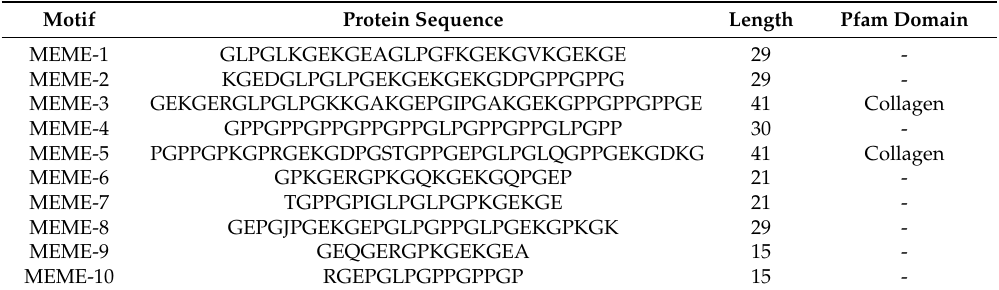
Figure 2. Phylogenetic relationships, motif pattern, gene structure, and conserved protein motifs of buffalo collagen gene family. ( A ) Phylogenetic tree of 45 collagen proteins. ( B ) Motif pattern of buffalo collagen gene family. Ten putative motifs are indicated in different colored boxes. For details of motifs refer to Table 1. ( C ) UTR/CDS organization of collagen genes. Yellow box, black line, and red box represent untranslated region (UTR), intron and coding sequencing (CDS), respectively. ( D ) Distributions of conserved protein motifs in collagen genes. Table 1. Ten different motifs commonly observed in buffalo collagen family.